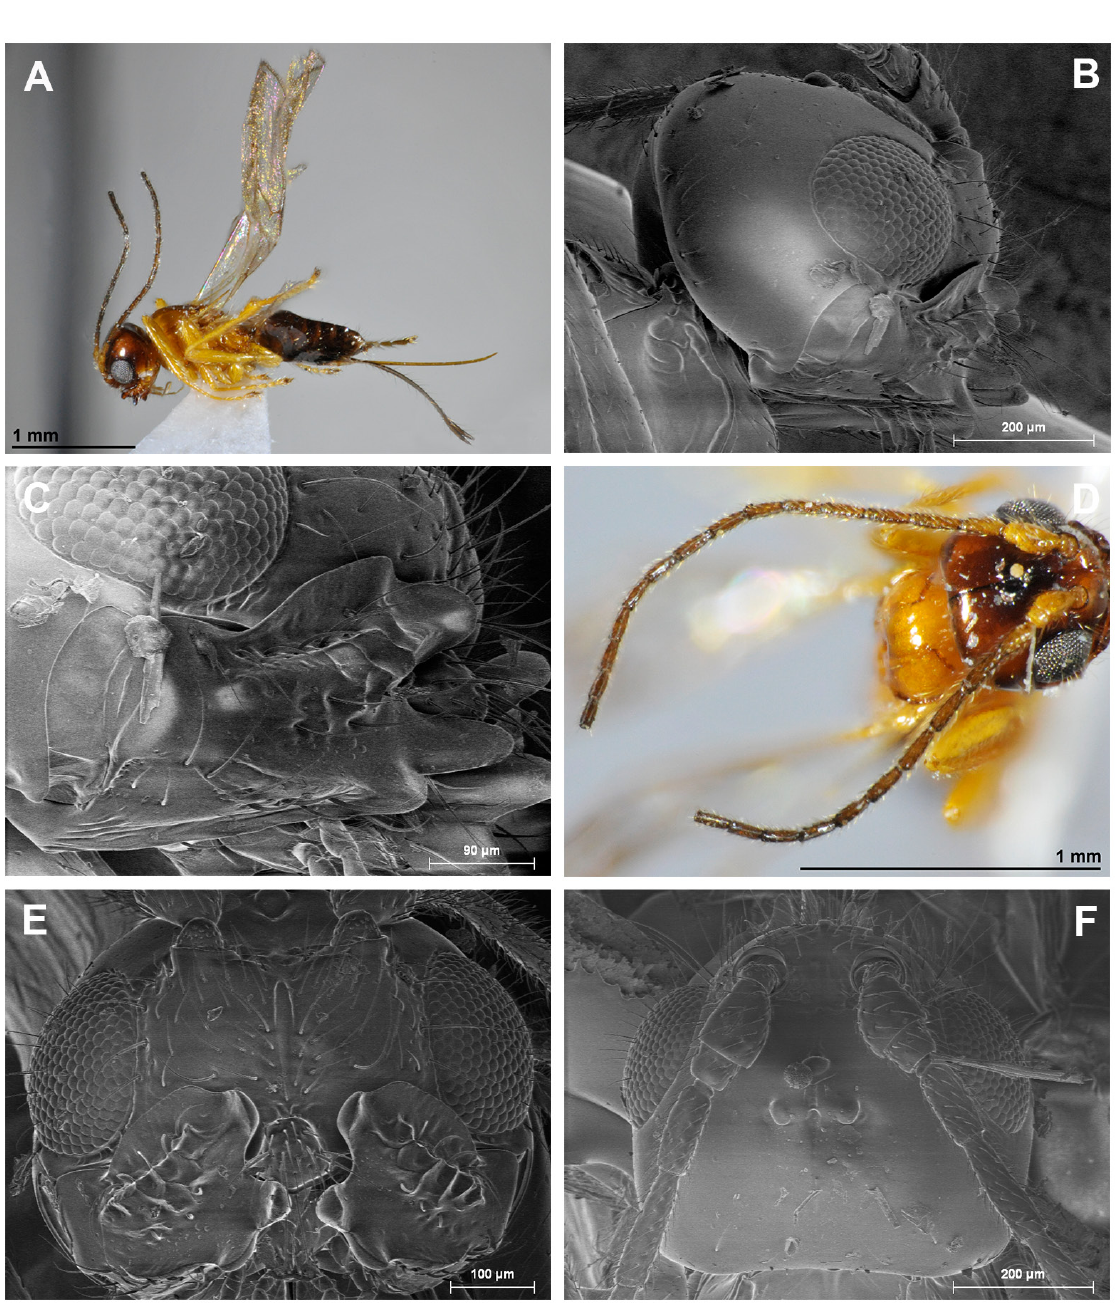
Fig. 52. Asobara rufimalawiana Fischer, 2007, ♀, holotype (OLML). A . Habitus, lateral view. B . Head, lateral view. C . Antenna. D . Mandible. E . Head, front view. F . Head, dorsal